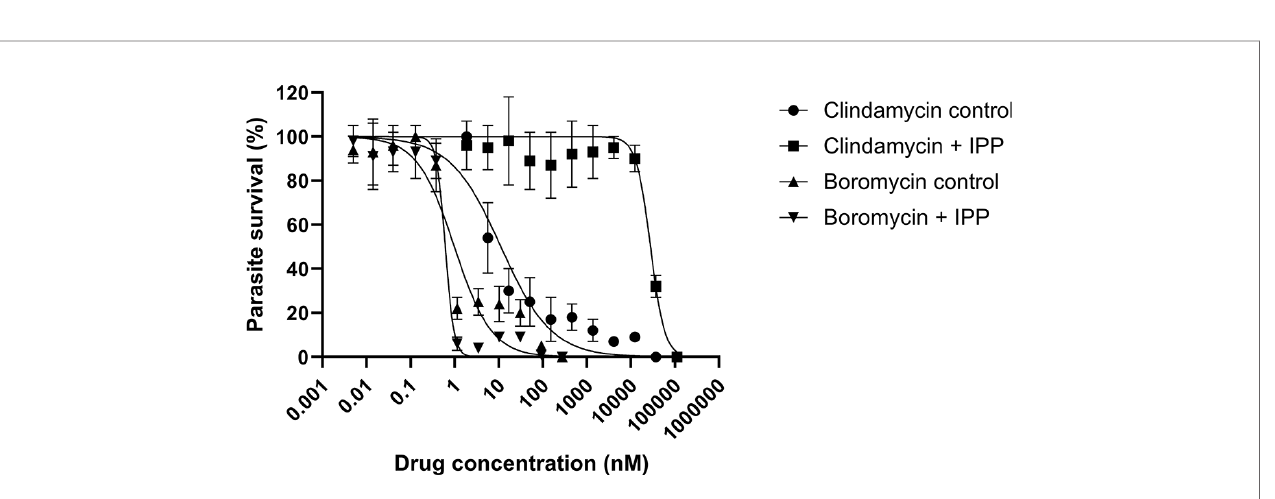
FIGURE 5 | Survival curves of isopentenyl pyrophosphate trilithium salt (IPP) rescue assays. Parasites of the P. falciparum strain 3D7 were treated with boromycin or clindamycin (positive control) with or without IPP supplementation and incubated for 6 days. Boromycin-treated parasites were not rescued by IPP, indicating that the apicoplast is not the main target. Experiments were done at least 3 times in duplicate.